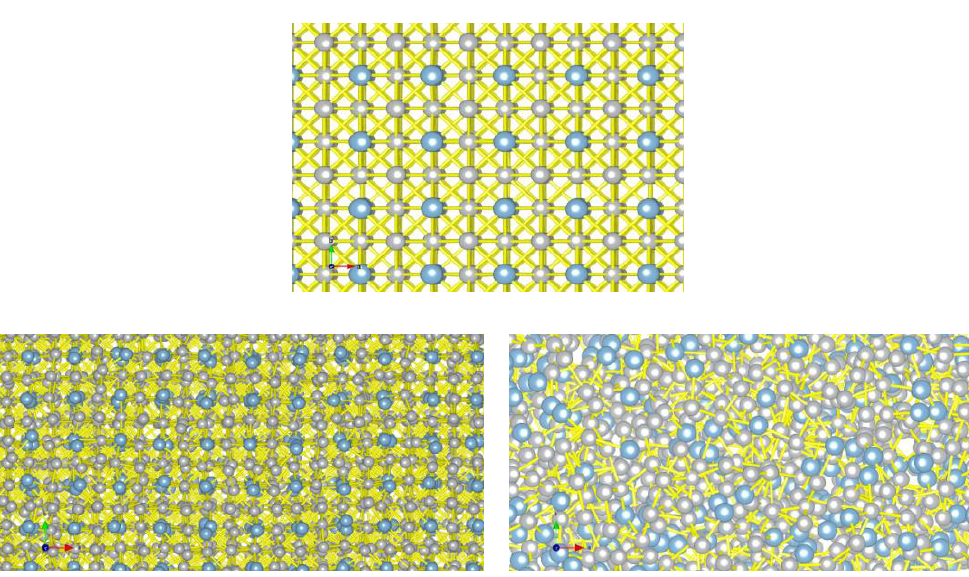
Figure 5. Molecular Dynamics results for the melting of Ni left T = 1000 K and bottom right T = 2000